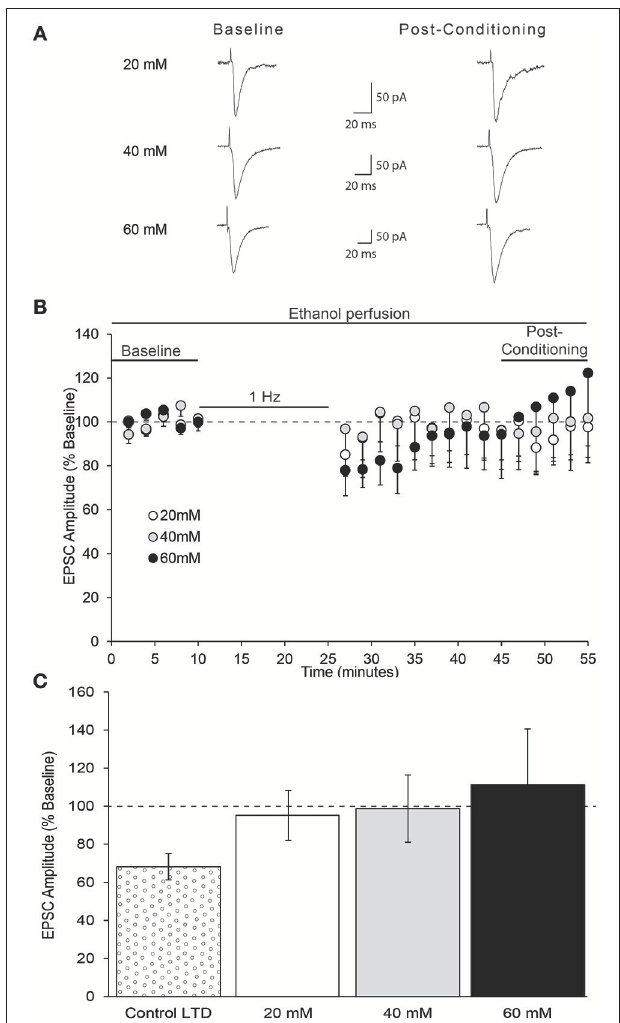
FIGURE 8 | In vitro ethanol exposure blocks AIC layer 2/3 pyramidal neuron LTD expression. (A) Representative traces from a single neuron of each ethanol group showing evoked EPSCs before and 20–30min after low-frequency conditioning stimulation protocol in the presence of acute ethanol. (B) Conditioning stimulation did not induce LTD expression in the presence of acute ethanol (20, 40, or 60mM). (C) Bar graph representing the average post-conditioning (min 45–55) EPSC amplitude as percentage of baseline for each ethanol concentration. Control LTD value from prior experiment ( Figure 6 ) shown for comparison. Values are expressed as averages ± S.E.M (Control LTD, n = 12 neurons/12 slices/9 mice; 20mM, n = 7 neurons/7 slices/5 mice; 40mM, n = 6 neurons/6 slices/5 mice; 60mM, n = 7 neurons/7 slices/5